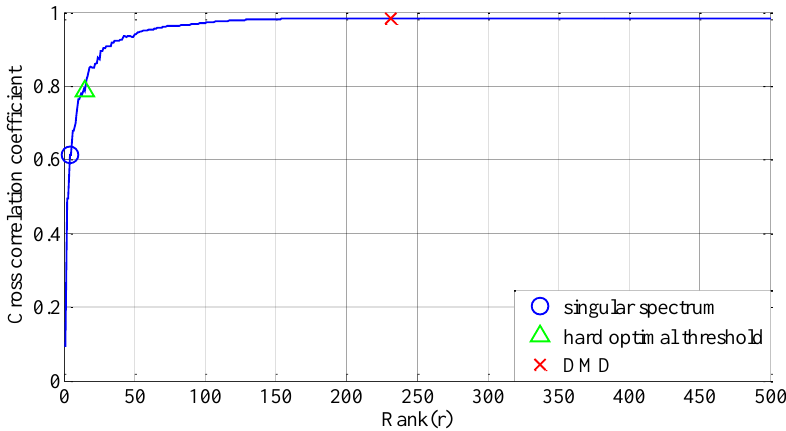
Figure 4. Cross correlation coefficient between DMD reconstruction signal and original simulation signal with different truncation rank r . Cross correlation coefficient is first ascending and then slightly declining. The rank ( r = 4) in blue circle point obtained by singular spectrum; the rank ( r = 13) with the green triangle point obtained by the hard optimal threshold; the rank ( r = 231) with a red cross mark obtained by our method.